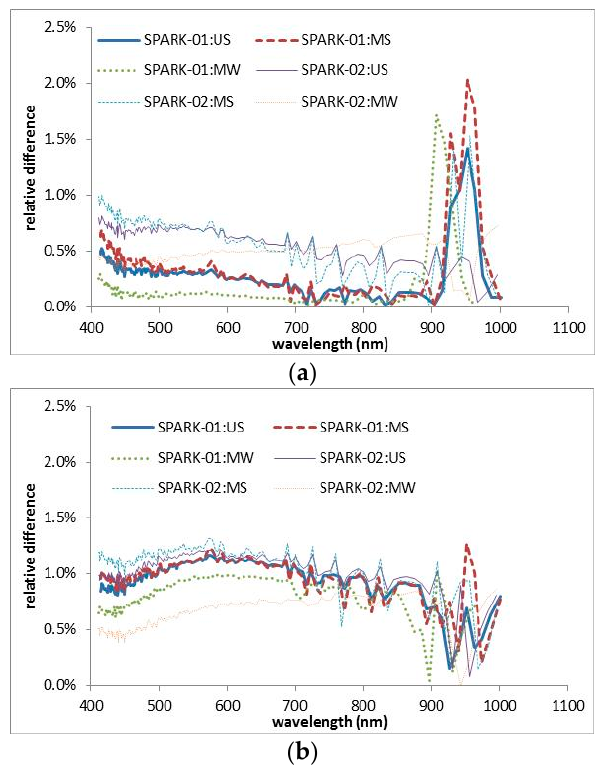
Figure 27. Calibration uncertainties caused by the vertical atmospheric profile measurements for SPARK-01 and -02 using the ( a ) reflectance- and ( b ) irradiance-based methods, respectively. “US,” “MS,” and “MW” refer to the relative difference in predicted radiance derived from replacing radiosonde measurements with these three atmospheric models.